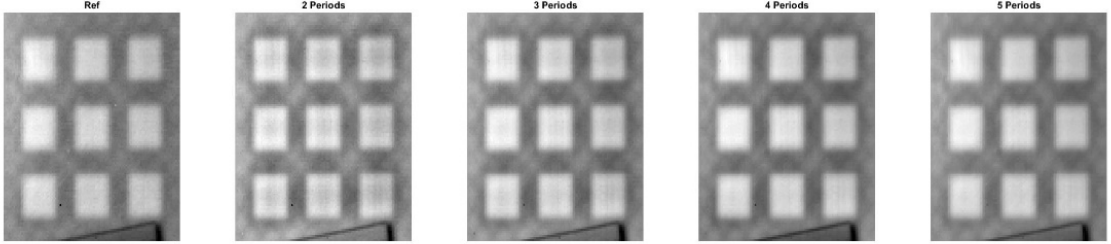
Figure 12. Phase images for the samples with the square cross section defects. A flash lamp was used as a source of excitation. Defects were placed 0.5 mm under the measured surface. Table 5. Comparation of phase images for measurement in the case of the halogen lamp and the fl ash lamp as source of excitation for defects place 0.5 mm under measured surface.